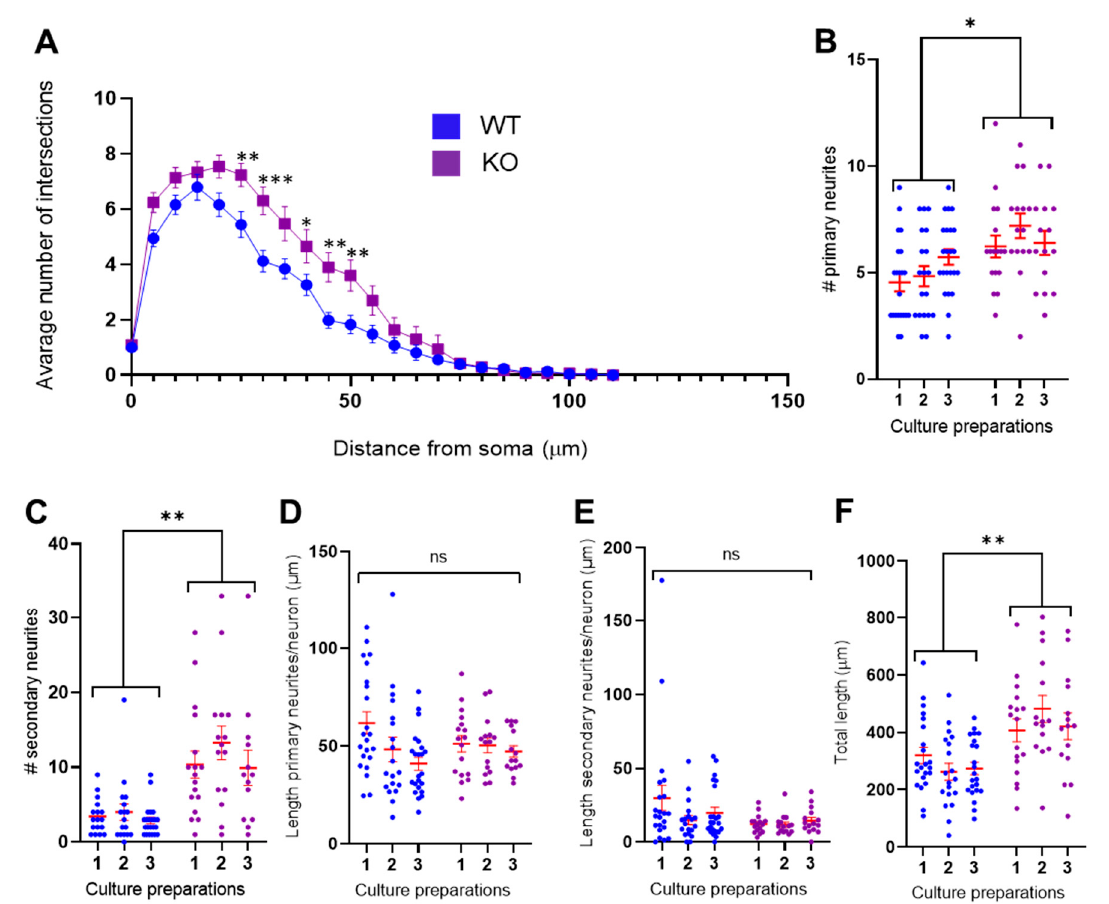
Figure 3. MT5-MMP deficiency alters neurite outgrowth in hiPSC-derived neurons. NPCs derived from wild-type and MT5-MMP KO hiPSCs were differentiated into neurons for 60 days before being subjected to the Sholl analysis. ( A ) Sholl analysis of dendrites from neurons of both genotypes (as indicated) showing the total number of intersections of MAP2B positive neurites with concentric rings, from the cell body to distal ends of dendrites (maximal distance of 110 μ m, steps of 5 μ m). MT5-MMP deficient neurons showed higher dendritic intersections in the 30 to 50 μ m distance from soma (two-way repeated-measures ANOVA with Bonferroni’s post hoc test, N = 3, n = 82, F (1, 80) = 10.7, *** p < 0.001; ** p < 0.01; * p < 0.05). ( B , C ) Bar charts depicting the counting of the number of primary ( B ) and secondary ( C ) neurites using the NeuronJ plugin. Noticeably, analyses showed that MT5-MMP deficiency significantly increases the number of primary (nested t-test, N = 3, n = 111, F = 10.0, * p = 0.03) and secondary neurites (nested t-test, N = 3, n = 111, F = 42.8, ** p = 0.003). ( D , E ) Bar charts depicting the average length of primary ( D ) and secondary ( E ) neurites. ( F ) Bar chart showing a significant increase of total length for MT5-MMP knockout neurons (nested t-test, N = 3, n = 111, F = 28.0, ** p = 0.006). Data are presented as mean ± SEM.